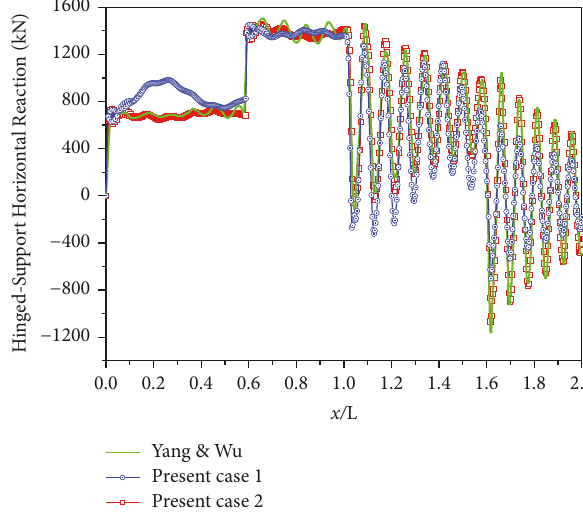
Figure 5: Vertical displacement of midpoint of simply supported beam.